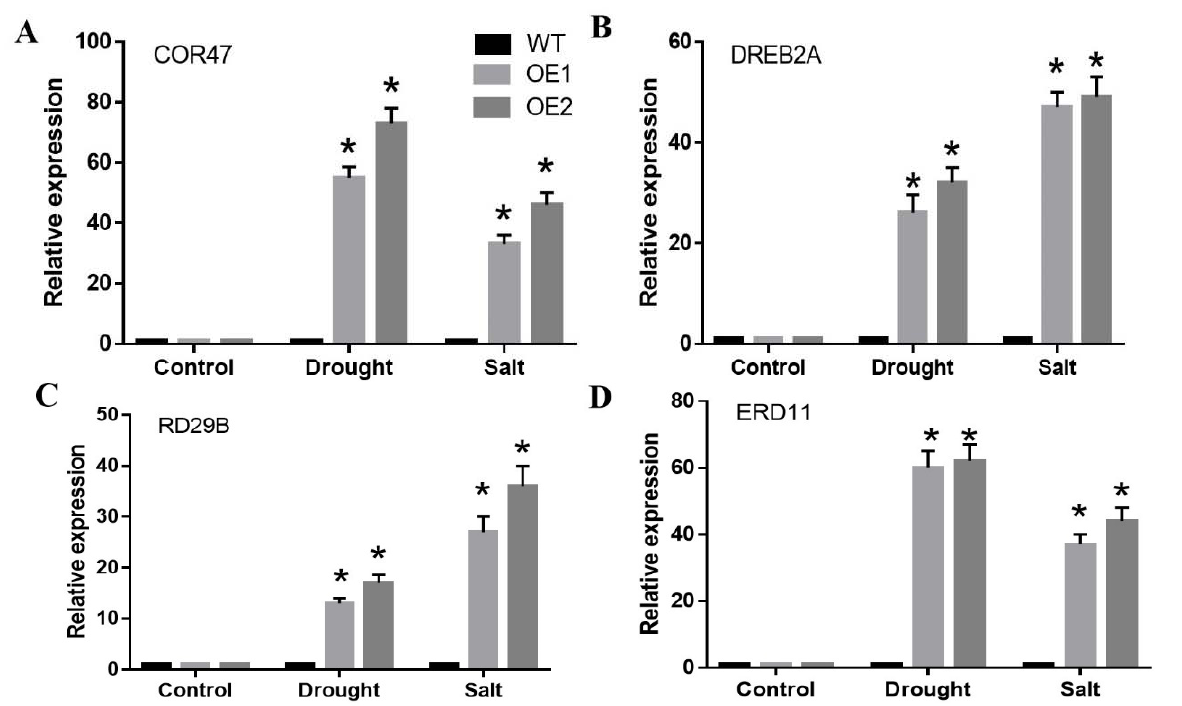
Figure 8. Overexpression of CaDHN3 activated the relative expression of the stress responsive genes. ( A ) Relative expression of COR47 under drought and salt stress. ( B ) Relative expression of DREB2A under drought and salt stress. ( C ) Relative expression of RD29B under drought and salt stress. ( D ) Relative expression of ERD11 under drought and salt stress. Mean and S.D. values were obtained from three independent experiments. Asterisks indicate statistical significance (* p < 0.05, Student’s test) compared to